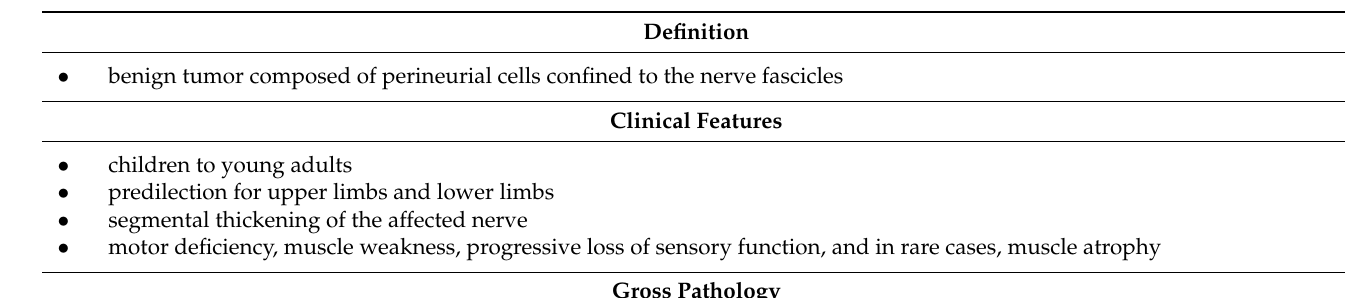
Table 13. Key diagnostic features of intraneural